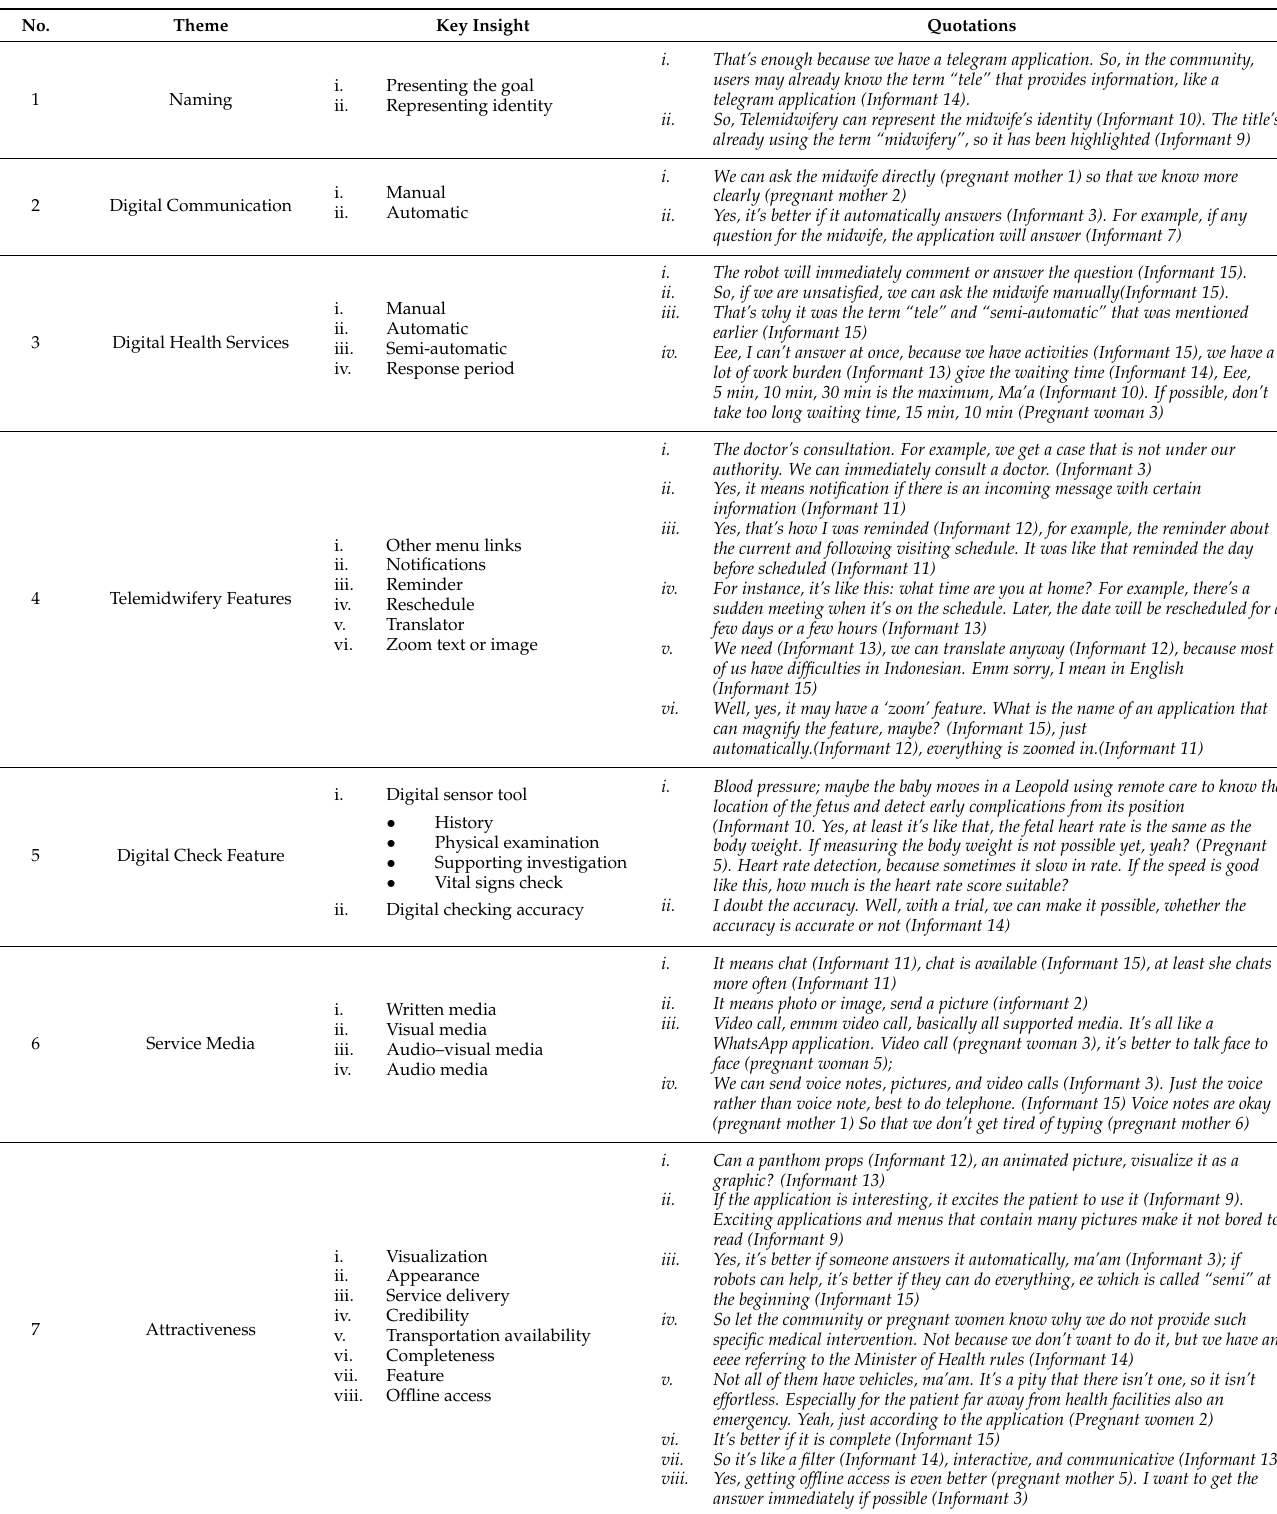
Table 1. Themes and Key Insights of Telemidwifery